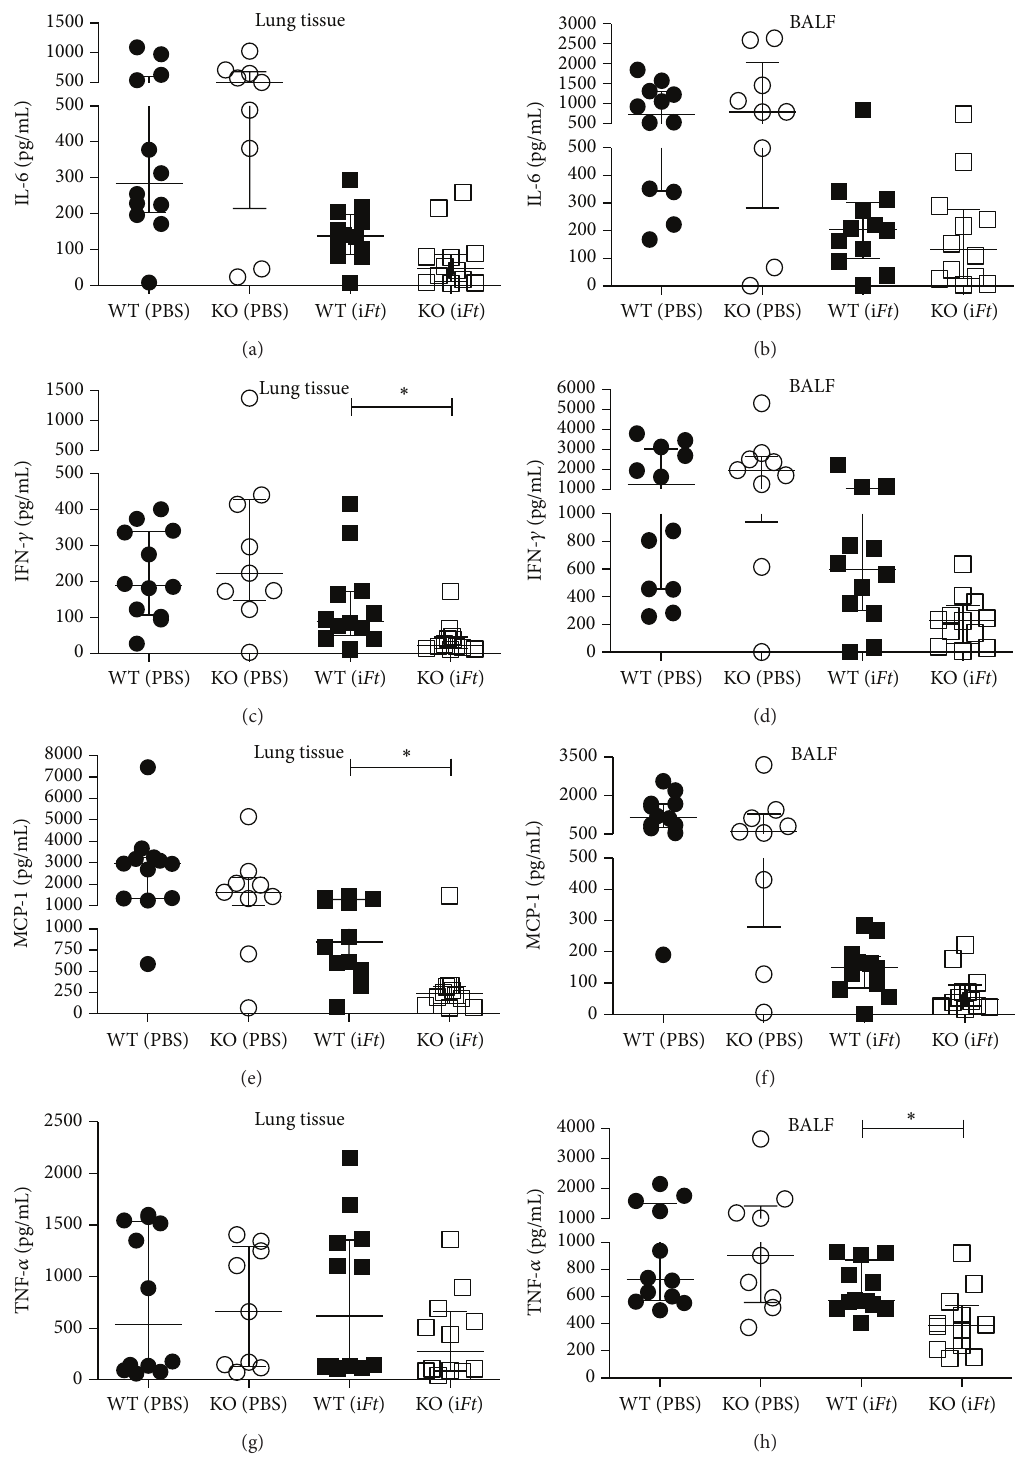
Figure 5: Levels of proinflammatory cytokines in the lungs of i Ft -immunized Fc 𝛾 RIIB KO versus WT mice were reduced 5 days after challenge. WT C57BL/6J and Fc 𝛾 RIIB KO mice were immunized i.n. with 20 𝜇 L of PBS (vehicle) or 2 × 10 7 i Ft -organisms in 20 𝜇 L of PBS on day 0 and boosted on day 21. On day 35 mice were given a sublethal challenge i.n. with approximately 0.4 × LD 50 . Five days after challenge lung tissue was collected, homogenized, and centrifuged and supernatants were collected. Luminex assay was performed on tissue supernatants to determine in vivo cytokine levels. Each symbol represents a single mouse. A value of 0.1 was added to the average cytokine concentration to correct for heteroscedasticity. A one-way ANOVA along with a Tukey’s multiple comparison test was performed on the log of the average cytokine concentration of lung and BALF samples from individual mice to determine statistical significance, and median and interquartile range is graphed. ∗ 𝑃 < 0.05